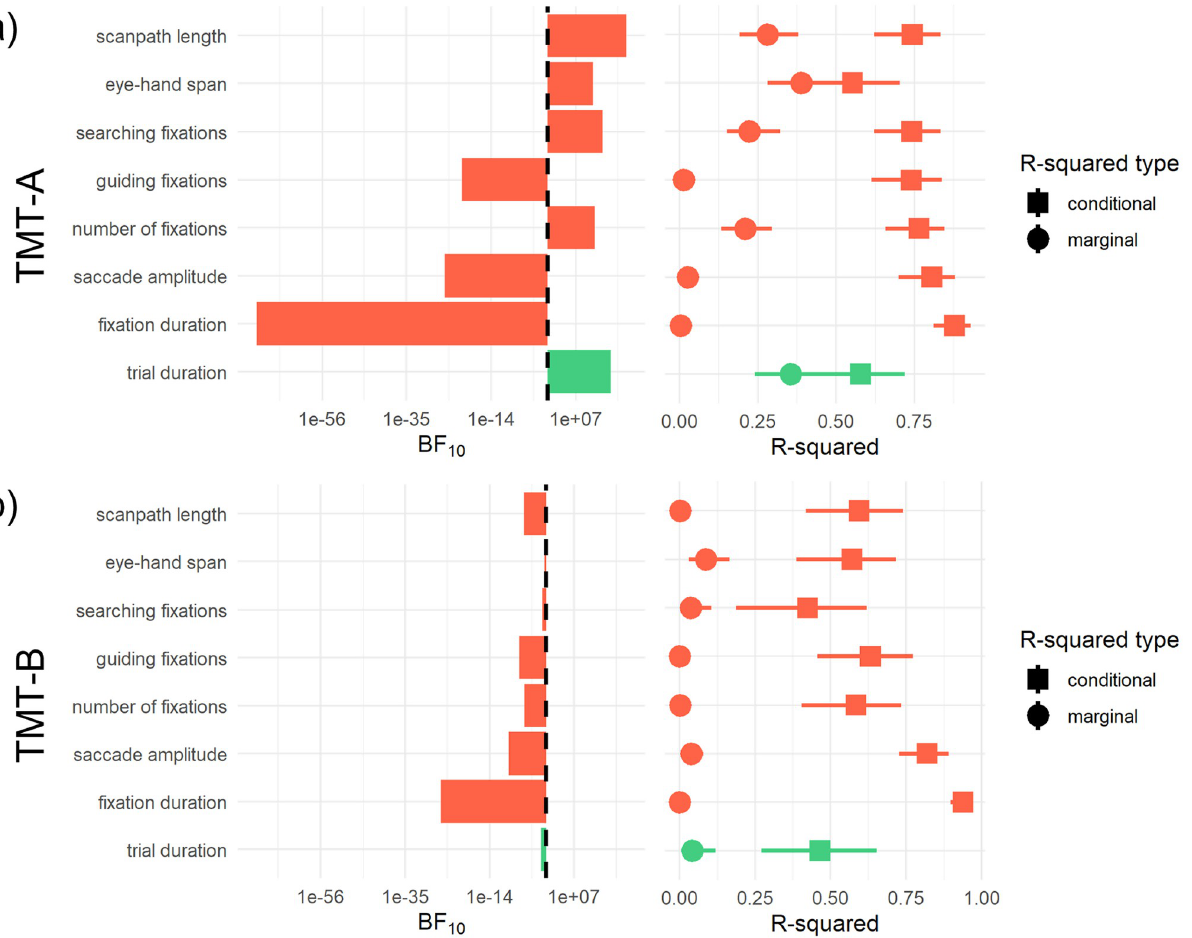
Fig 3. Variables dominated by the individual variability vs. the speed-accuracy manipulation. Results of the analyses for R-squared values and the Bayes Factor comparison of fixed versus random effects in the model for each examined dependent variable in TMT-A (Fig 3a) and TMT-B (Fig 3b). Error bars in the R-squared plot represent bootstrapped 95% C.I. All variables related to eye movement control are plotted in red. All variables related to classic TMT measures, i.e. trial duration, are plotted in